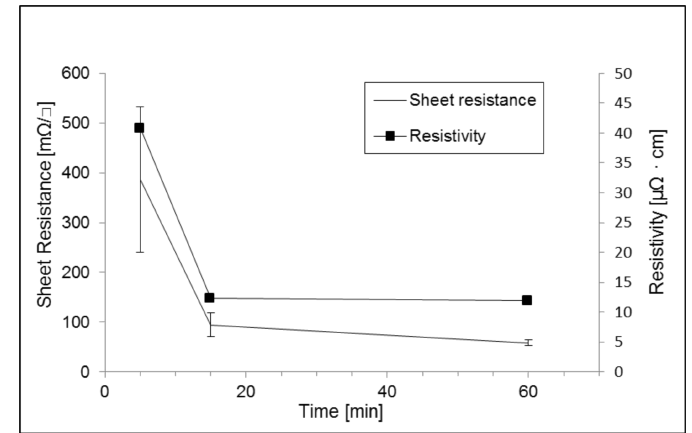
Figure 9. Sheet resistance and coating resistivity of the 40 mm × 40 mm